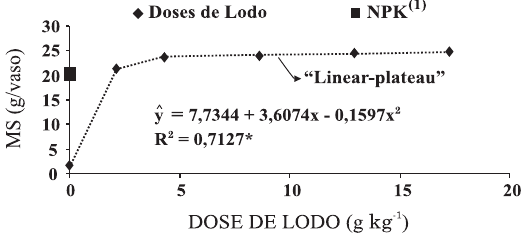
Figura 4. Variação da produção de matéria seca (MS) das plantas de milho em função das doses de lodo anaeróbio da estação de tratamento de efluentes de parboilização de arroz. (1) Tratamento NPK incluído como referência fora da análise de